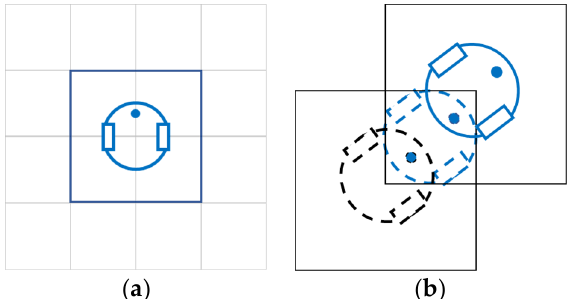
Figure 3. ( a ) Robot lies in the middle of the search window; ( b ) robot moves in a diagonal line without partial unobservable route.